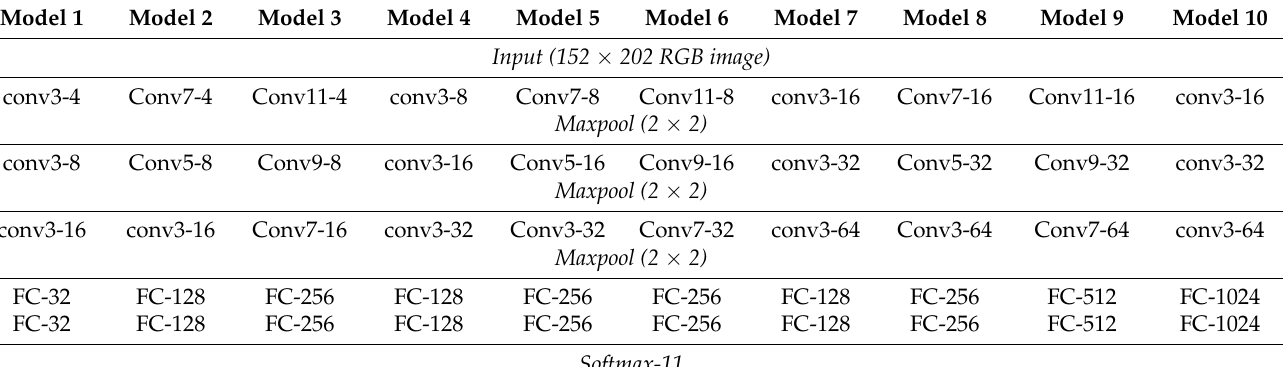
Table 3. Custom models of various complexity ((conv A - B means a convolutional layer with B filters of an A × A size, FC- C is a fully connected layer with C neurons, and Softmax- D is a softmax layer with D outputs).